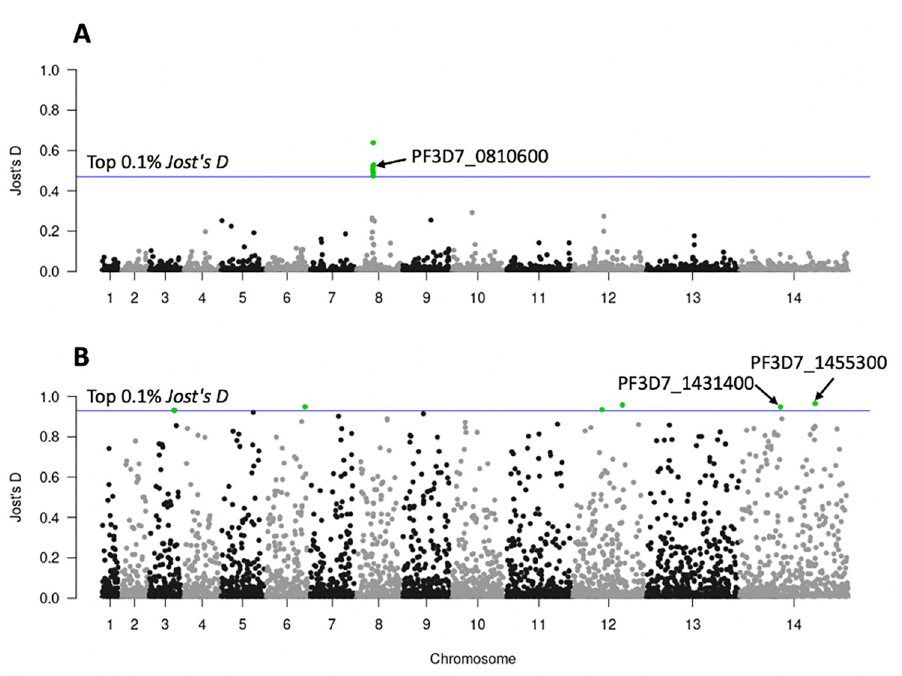
Fig 5. Genome scans for differentiation, as measured by Jost’s D values. (A) CAF, EAF, and WAF samples. (B) Africa region (CAF, EAF, WAF) with Southeast Asia (WSEA, ESEA) region samples. The x-axis represents the chromosomes and the y-axis represents the Jost’s D values. Each point represents one STR locus with a total 6,768 STRs represented. The blue horizontal line represents the threshold based on the top 0.1% Jost’s D values.